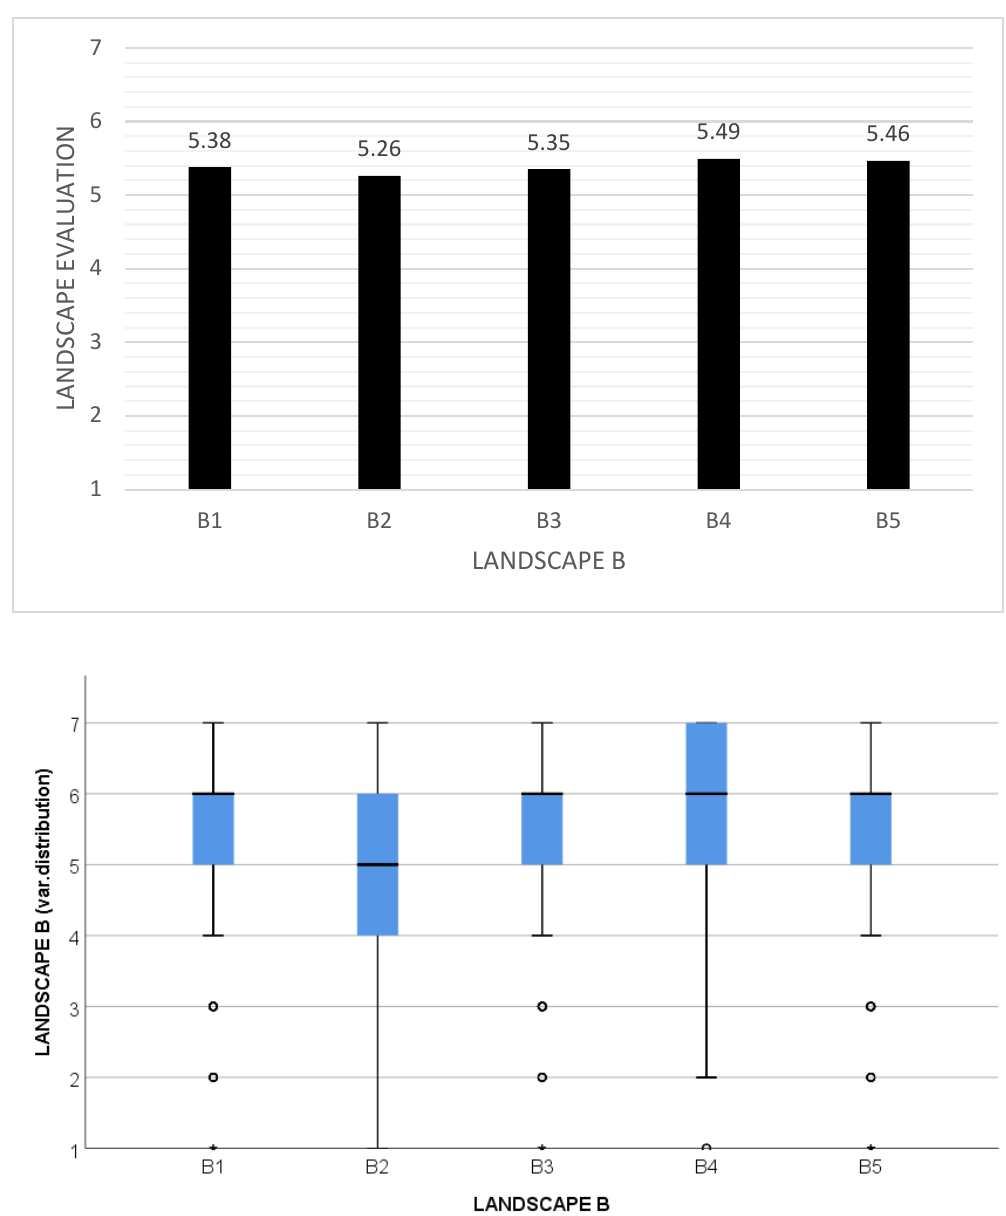
Figure 4. Evaluation of landscape types A and B (top—average values, bottom—variable distribution) with varying plot sizes A1–A5 and B1–B5, based on a 7-point Likert-type scale ranging from 1 (very ugly) to 7 (very beautiful). In both these landscape types with low baseline landscape heterogeneity, we found a significant preference for smaller agricultural plots ( p = 0.003 for landscape A and p < 0.001 for landscape B).